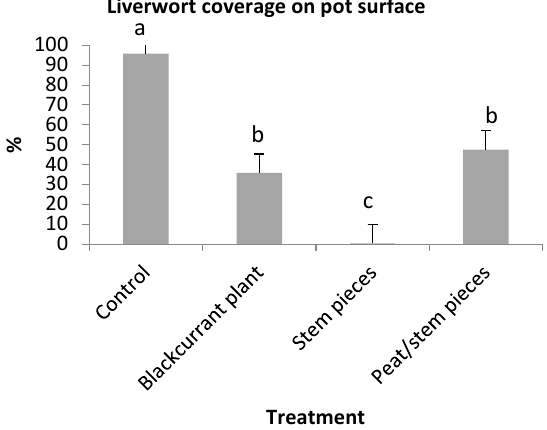
Fig. 4. Liverwort average coverage % and SE on pot surface of different treatments in October. Different letters indicate statistical difference at p≤0.05. Treatment